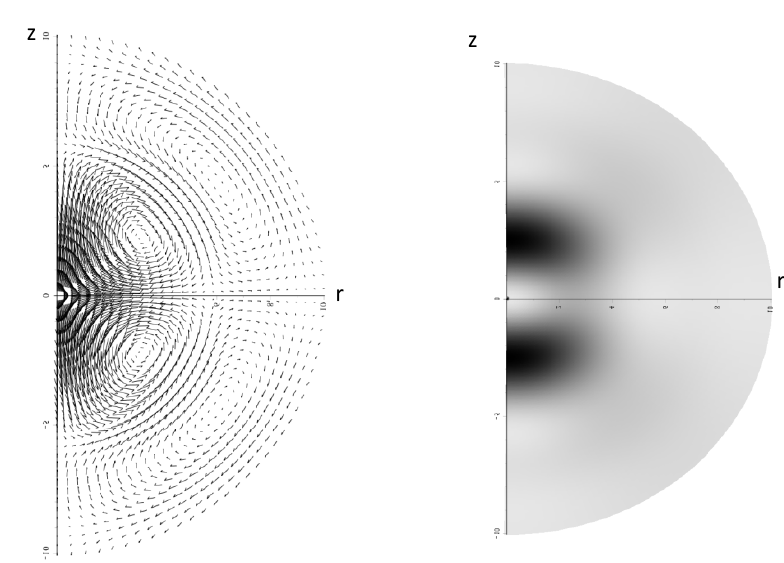
Fig. 16. Velocity and pressure of the second-order spherical